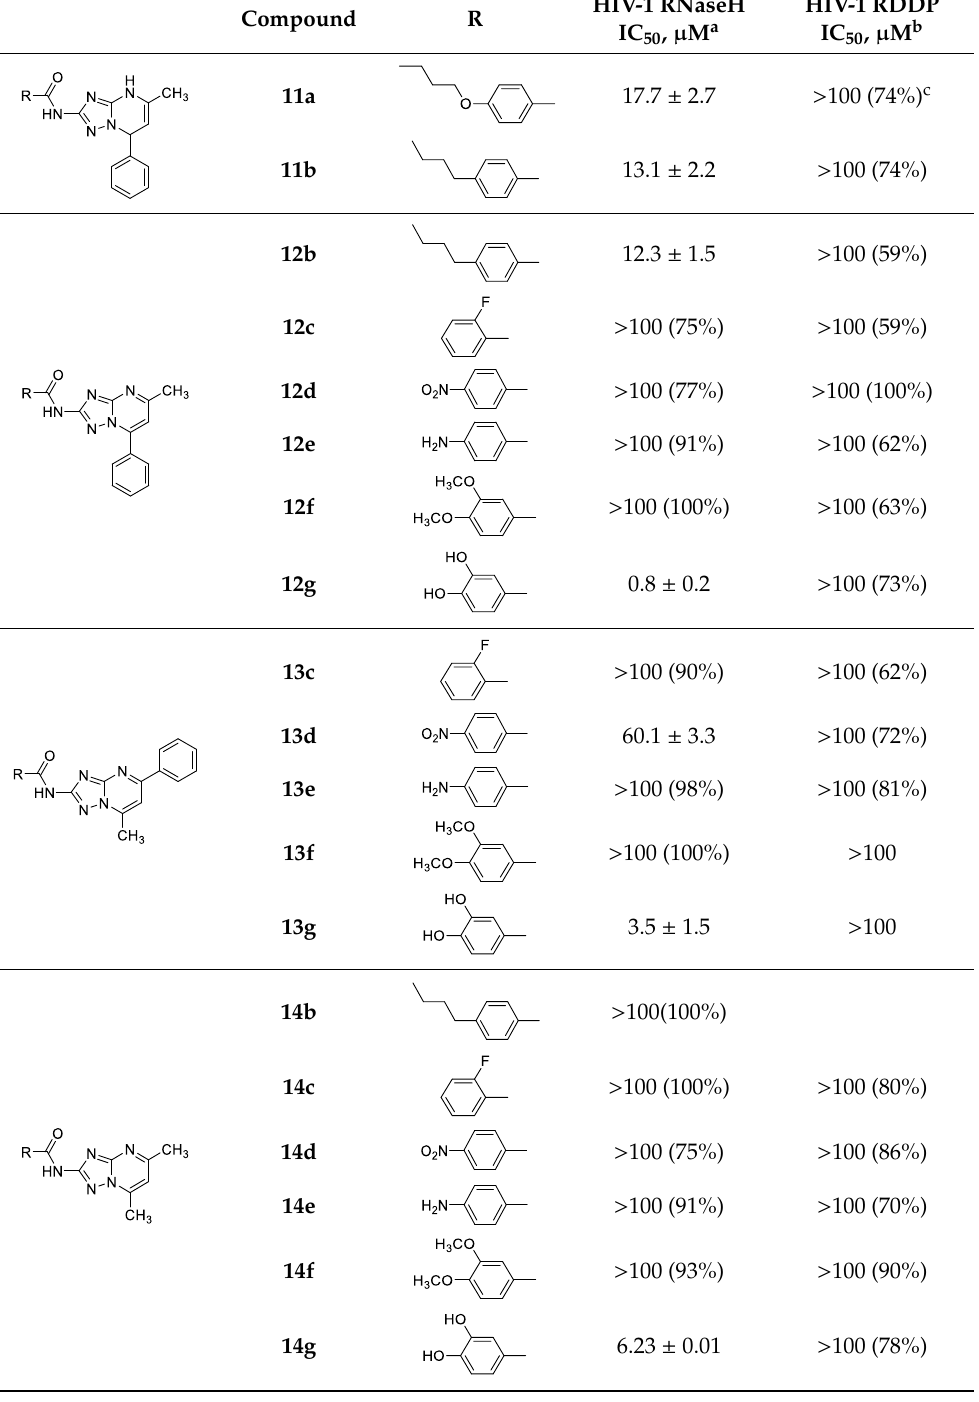
Table 1. Activity of TZP derivatives on the HIV-1 RT-associated RNase H and RDDP functions.